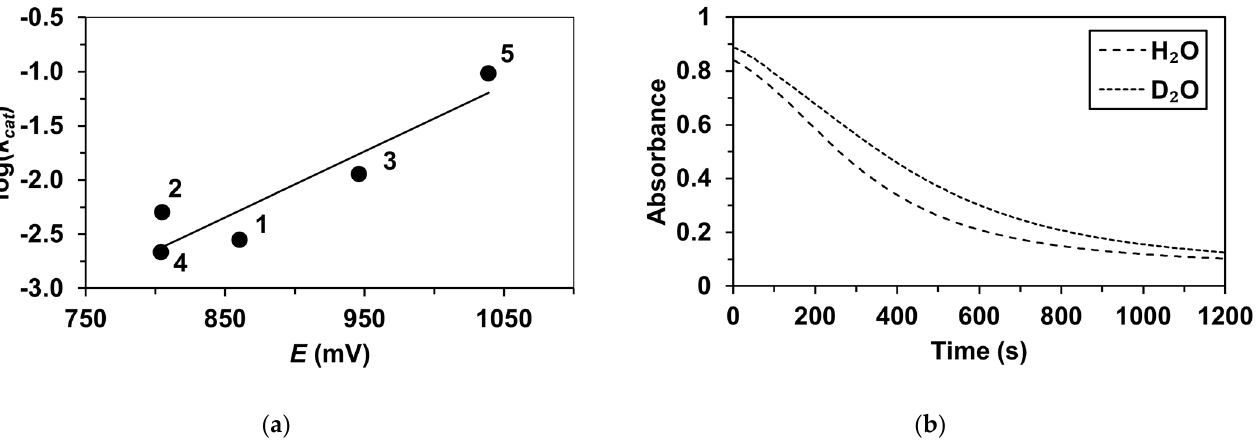
Figure 14. Peroxo-diiron(III)-mediated disproportionation of H 2 O 2 in MeCN at 298 K. ( a ) Dependence of the reaction rate ( k cat ) for H 2 O 2 oxidation on the redox potential ( E 1/2 ) of the [Fe II (L 1 − 5 ) 3 ] 2+ ( 1 – 5 ) complexes. ( b ) Kinetic isotope effect ( KIE ) on the disproportionation of H 2 O 2 . [ 4 ] 0 = 1.0 × 10 − 3 M, [H 2 O 2 ] 0 = 0.05 M, [H 2 O or D 2 O] 0 = 2.8 M (100 µ L) in